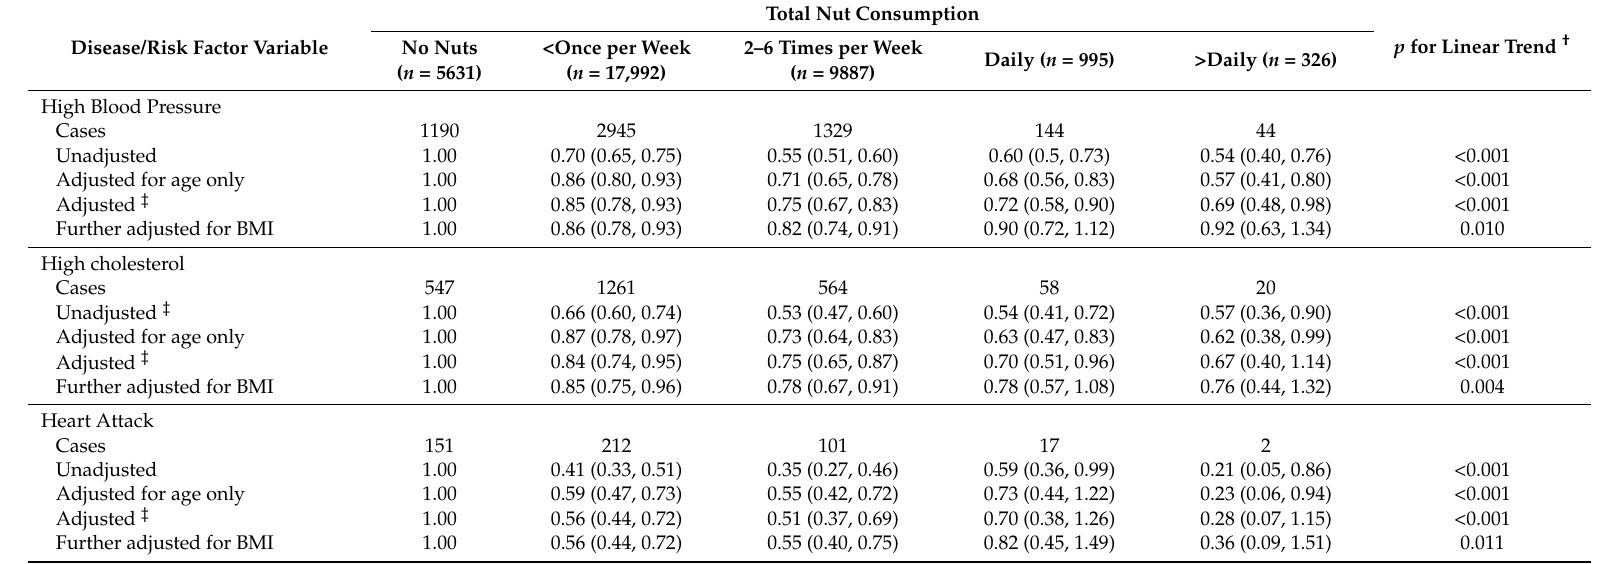
Table 4. Odds ratio (95%CI) for chronic disease and risk factors for chronic disease by nut